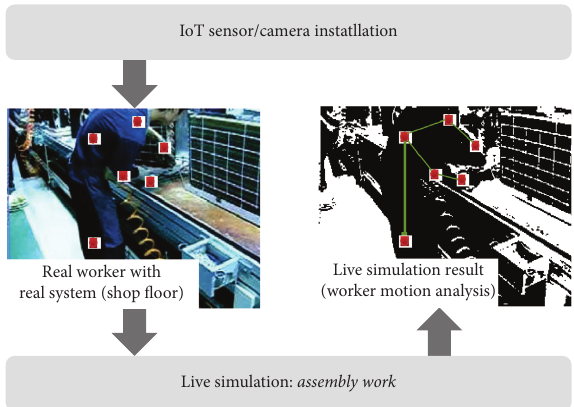
Figure 3: Application of live simulation in smart